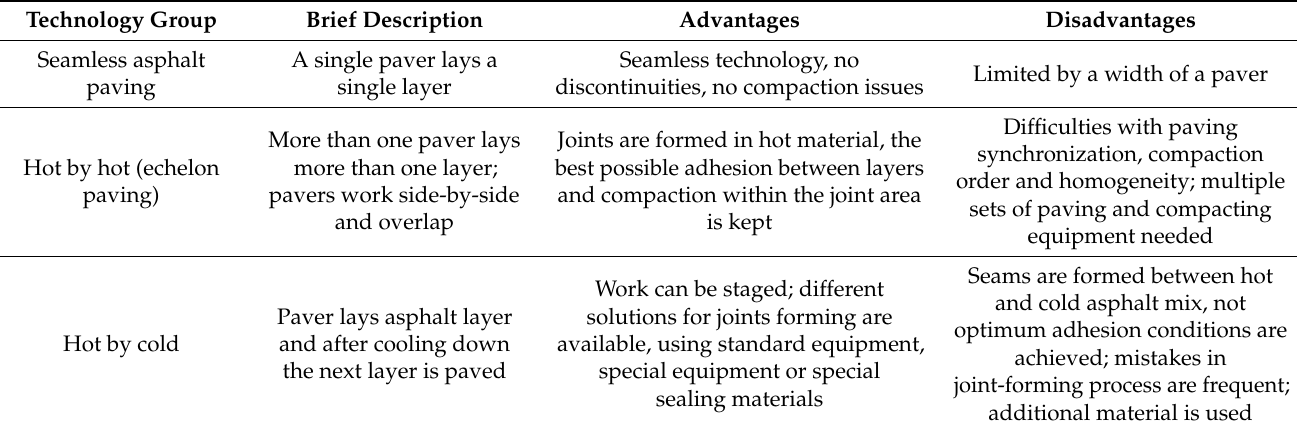
Table 1. Main groups of pavement longitudinal joints forming